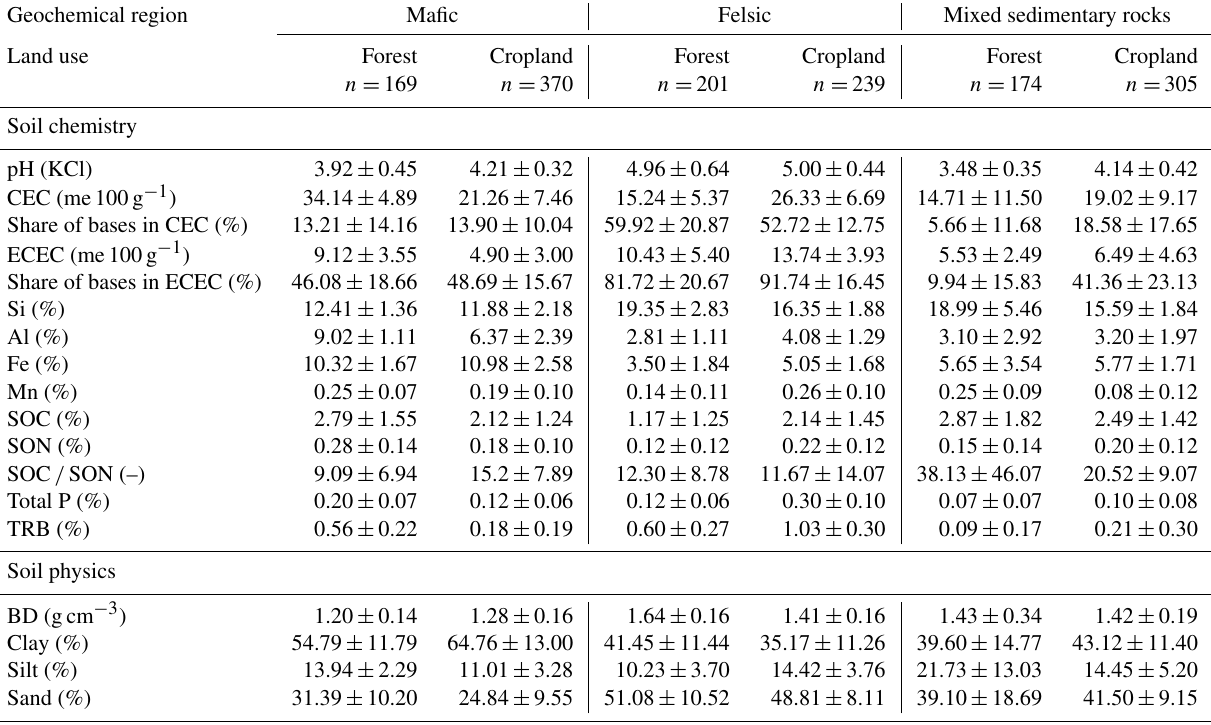
Table A1. Basic chemical and physical soil parameters aggregated at land use and geochemical regions. Displayed are average values and standard deviations taken over 10 soil increments at 10cm from 0–100cm soil depth derived from NIR-MIR spectral data, calibrated on samples from three depth increments (0–10, 30–40, and 60–70cm). See metadata files 223_soil_spec.pdf and 323_soil_spec.pdf